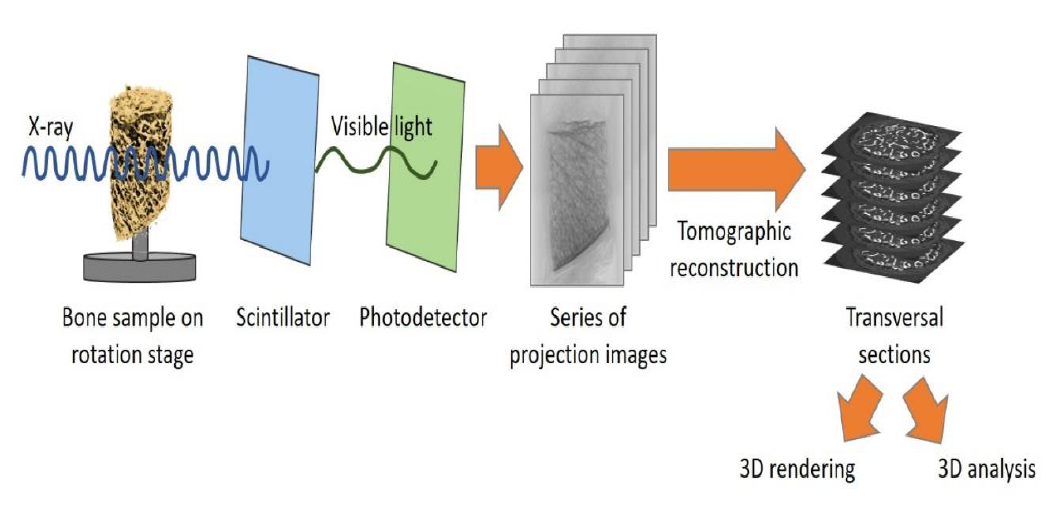
Figure 11. Schematic representation of the conversion of X-ray adsorption information into the transversal slices of the sample.